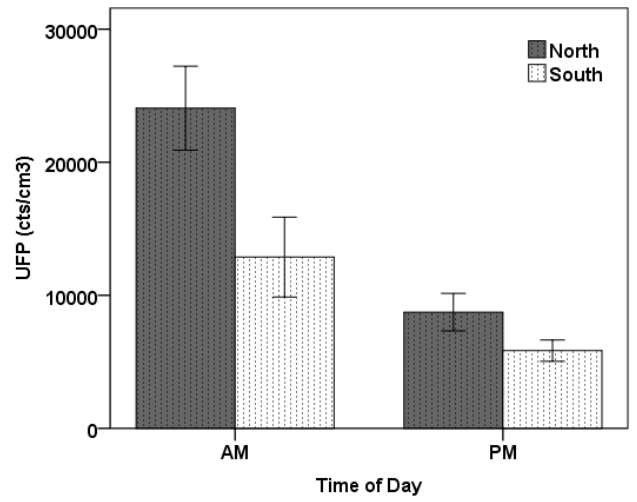
Figure 6. Mean UFP concentration for the Moorhead Road segment. The error bars are the standard errors of the mean (SEM) for the five commutes in each category.